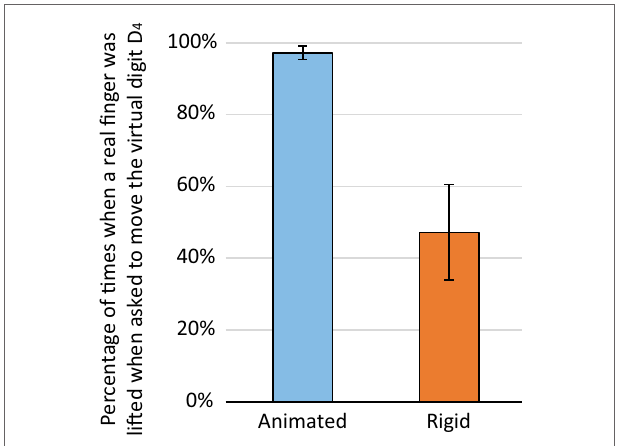
FigUre 4 | Percentage of times when participants made a voluntary finger motion when asked to lift the additional virtual digit D 4 , independently of the real finger they decided to move . Results are averaged over both tasks as we did not find a main or interaction effect of Task . Vertical bars depict